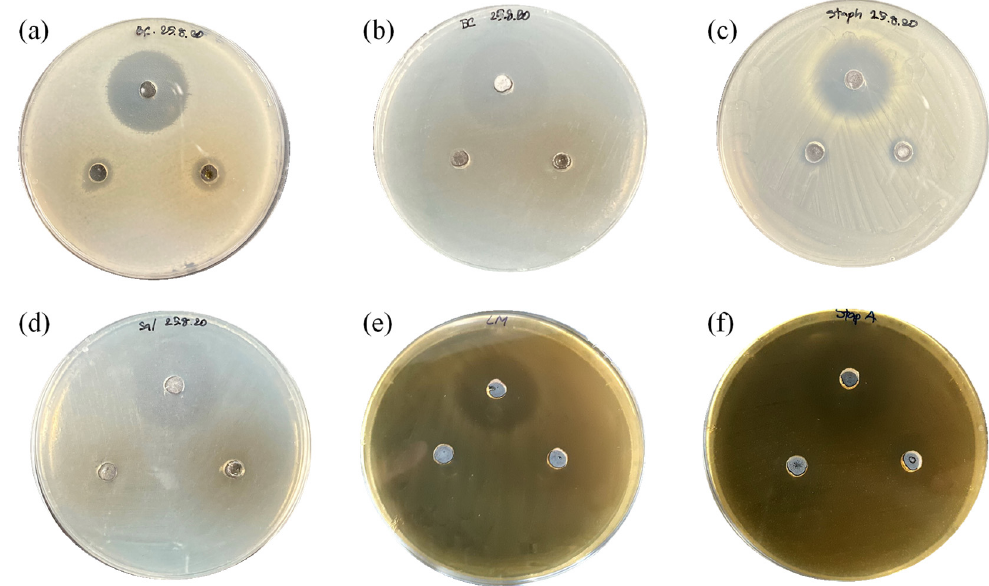
Figure 4. Antimicrobial activity of cell-free extract of S. ruineniae A45.2 cultivated in tannic acid substrate at 30 °C for 24 (left) and 48 h (right) of cultivation against ( a ) B. cereus , ( b ) E. coli , ( c ) Staph. aureus , ( d ) Sal. Thyphimurium, ( e ) L. monocytogenes and ( f ) Strep. agalactiae compared to control (top) (50 μ g/mL chloramphenicol) 3.4. Carotenoids Produced by S. ruineniae